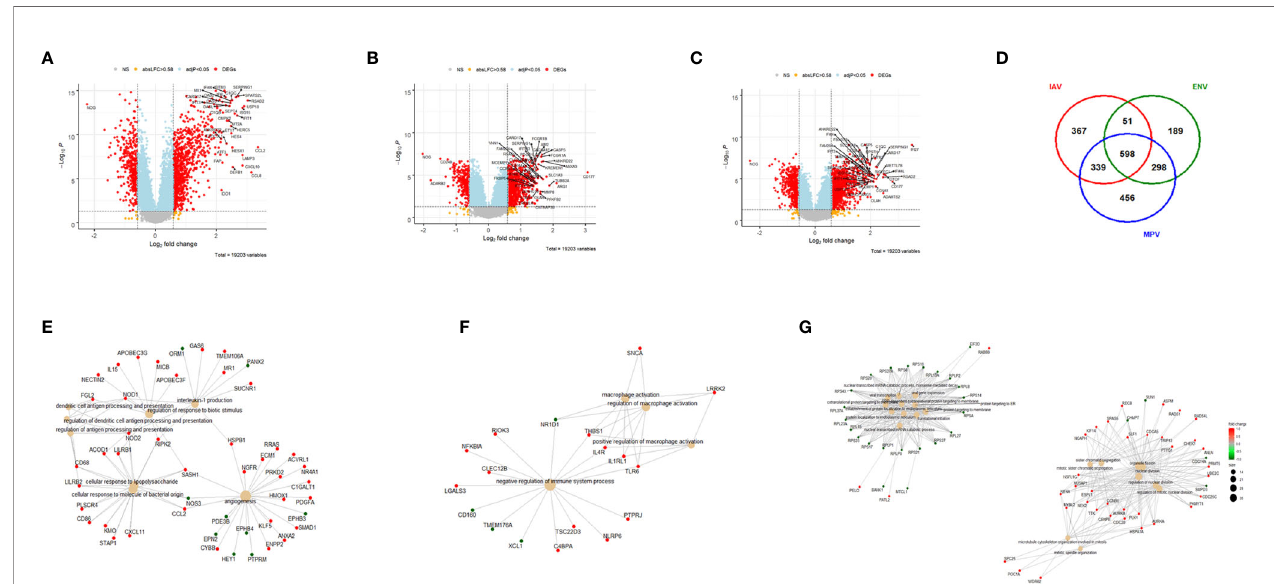
FIGURE 1 | Host responses in IAV, ENV and MPV infections versus healthy controls. (A) Volcano plot of results of the contrast from the linear regression analysis of in fl uenza virus infected versus healthy controls. y-axis: -log 10 BH multiple testing adjusted p-values, x-axis: log 2 fold change. DEGs (absolute log-fold change > 1.5, corresponding to a log 2 -fold change > 0.58; multiple testing adjusted p-value < 0.05) are colored red and the top 40 most strongly regulated (by log-fold change) DEGs are labeled. Blue: genes with adjusted p-value < 0.05. (B) Volcano plot of results of the contrast from the linear regression analysis of entero/rhino virus infected versus healthy controls. y-axis: -log 10 BH multiple testing adjusted p-values, x-axis: log 2 fold change. DEGs (absolute log-fold change > 1.5, corresponding to a log 2 -fold change > 0.58; multiple testing adjusted p-value < 0.05) are colored red and the top 40 most strongly regulated (by log-fold change) DEGs are labeled. Blue: genes with adjusted p-value < 0.05. (C) Volcano plot of results of the contrast from the linear regression analysis of MPV infected versus healthy controls. y-axis: -log 10 BH multiple testing adjusted p-values, x-axis: log 2 fold change. DEGs (absolute log-fold change > 1.5, corresponding to a log 2 -fold change > 0.58; multiple testing adjusted p-value < 0.05) are colored red and the top 40 most strongly regulated (by log-fold change) DEGs are labeled. Blue: genes with adjusted p-value < 0.05. (D) Venn diagram illustrating the overlaps between the DEGs from contrasts of IAV, ENV and MPV versus controls. A total of 2,298 DEGs were identi fi ed in all three infections (all genes combined part), 598 DEGs were commonly shared between the three infections (central part). IAV: DEGs from in fl uenza versus healthy controls, ENV: DEGs from enterovirus/rhinovirus versus healthy controls, MPV: DEGs from human metapneumovirus versus healthy controls. (E) Functional analysis using GO term enrichment for the genes from the Venn diagram for IAV DEGs. Network of top 20 pathways and associated genes. Red: up- regulated, green: downregulated. (F) Functional analysis using GO term enrichment for the genes from the Venn diagram for ENV DEGs. Network of top 20 pathways and associated genes. Red: up-regulated, green: downregulated. (G) Functional analysis using GO term enrichment for the genes from the Venn diagram for MPV DEGs. Network of top 20 pathways and associated genes. Red: up-regulated, green: downregulated. NS, not signi fi